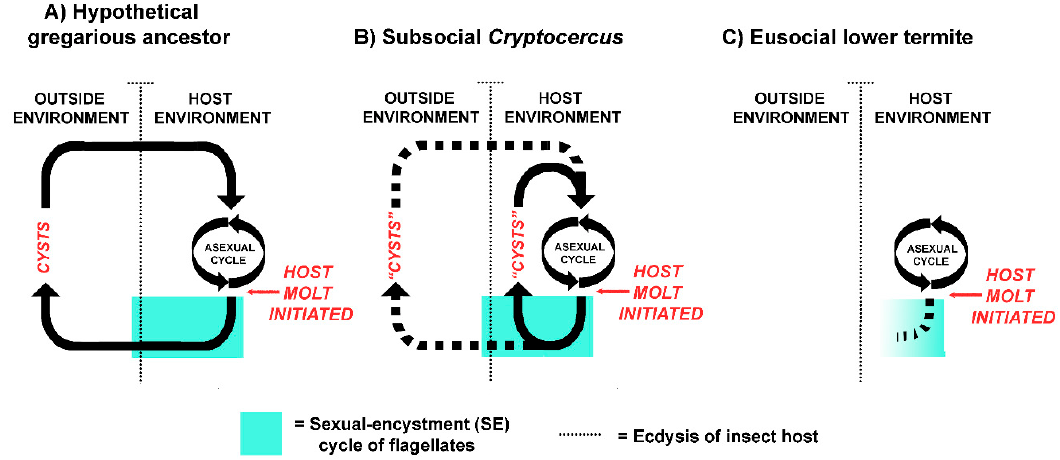
Figure 2. Sexual-encystment cycles of the flagellates in molting individuals of: ( A ) a hypothetical gregarious cockroach ancestor, ( B ) the subsocial cockroach Cryptocercus , and ( C ) eusocial lower termites. The symbiont-host relationship logically evolved in sequence, along with shifts in host social behavior, from a distant gregarious cockroach ancestor, to a subsocial Cryptocercus -like ancestor, to eusocial termites [18]. In both Cryptocercus and termites, the SE cycle has degenerated from the strong encystment pattern likely shown by an ancestor, but in both taxa, protistan numbers and functions are reliably restored after molt, albeit in different ways (retention of protists in individuals of Cryptocercus , anal trophallaxis from nestmates in termites). Neither Cryptocercus nor termite protists currently have a functional relationship with the external environment. Inspired by Weedall and Hall ([103] Figure 1). With Cryptocercus as model, proctodeal trophallaxis evolved from this pre-existing intraspecific coprophagous behavior when termite ancestors became semelparous and subsocial, because the physiology of encystment in the flagellates precludes their transfer via cysts in adult feces: adults don’t molt, and older developmental stages are not present in the social group. This was a key point in their evolutionary history, as it assured vertical intergenerational transmission of all pro- and eukaryotic members of the gut microbiome, led to growing interdependence of the host and symbionts, and established the behavioral basis of trophallactic exchanges [18,51]. Parent to offspring proctodeal trophallaxis in both Cryptocercus and termites during colony initiation is currently a mechanism of both inoculating neonates with the symbionts and of supplying them with nourishment until their microbiome becomes established. Table 1 summarizes the similarities and differences in the host-symbiont relationship in Cryptocercus and lower